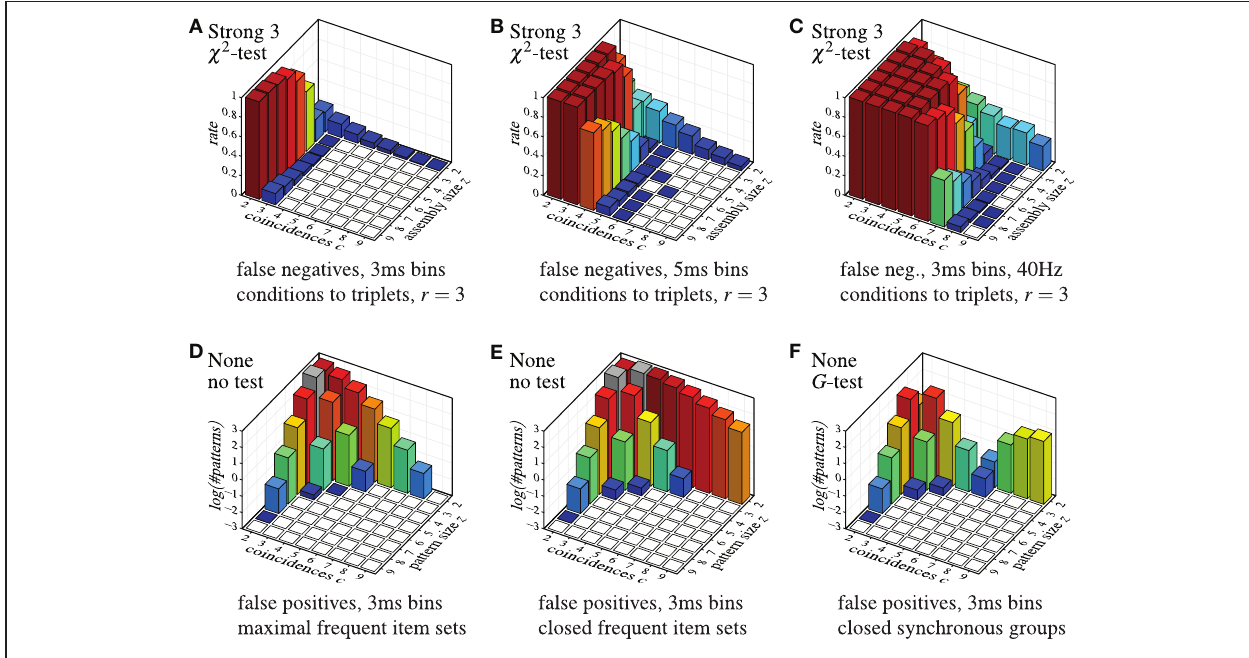
conditions down to triplets, and the effect of using closed instead of maximal sets or synchronous groups. Note the logarithmic scale (decimal logarithm) of the vertical axis of the false positive bar